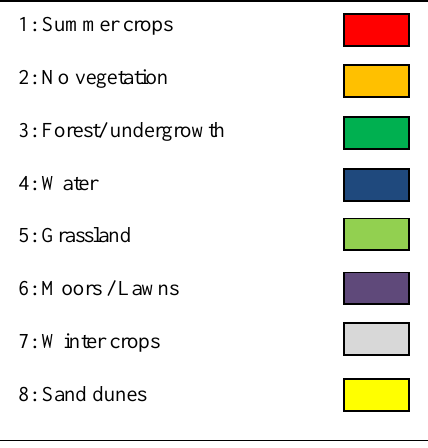
Figure 2. Vegetation classes and No